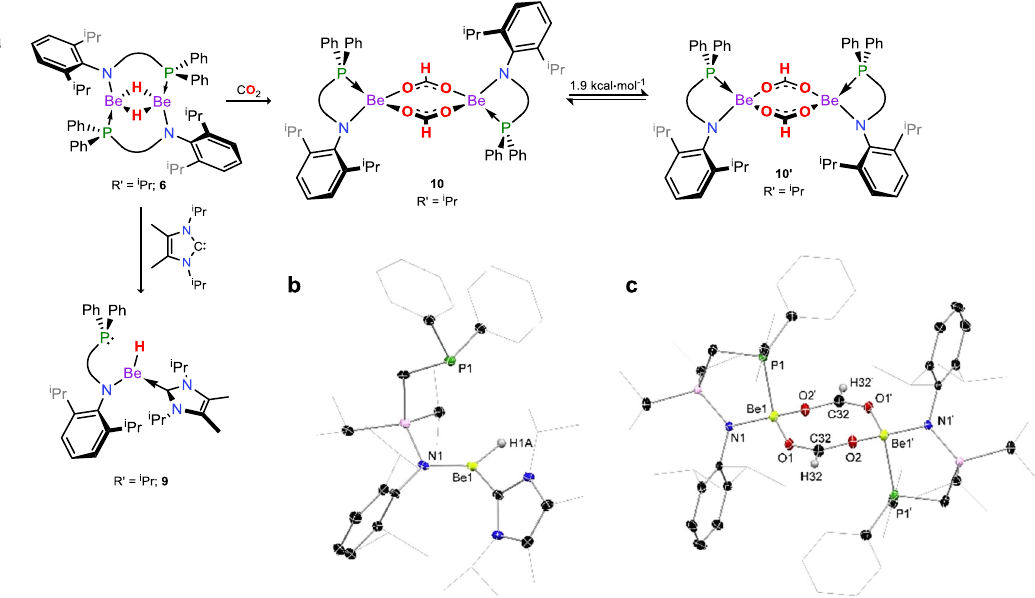
Fig. 3 Synthesis and X-ray crystal structures of compounds 9 and 10. Addition of an NHC to the dimeric amido-beryllium hydride complex 6 leads to the 3-coordinate beryllium hydride complex 9 , whilst addition of CO 2 to 8 leads to insertion into the Be – H bond, forming beryllium formate 10 , which shows structural fl uctionality in solution. a Synthesis of compounds 9 and 10 from dimeric beryllium hydride complex 6 . b Solid state structure of complex 9 . c Solid state structure of complex 10 . Thermal ellipsoids for 9 and 10 at 30% probability. Selected distance (Å) and angles (°) for 9 : Be1 – H1A 1.36(3); Be1 – C32 1.800(5); Be1 – N1 1.616(4); Be1 ∙∙∙ P1 3.537(4). For 10 : Be1 – O1 1.623(3); Be1 – O2 1.631(3); O1 – C32 1.253(3); O2 – C32 1.252(3); Be1 – N1